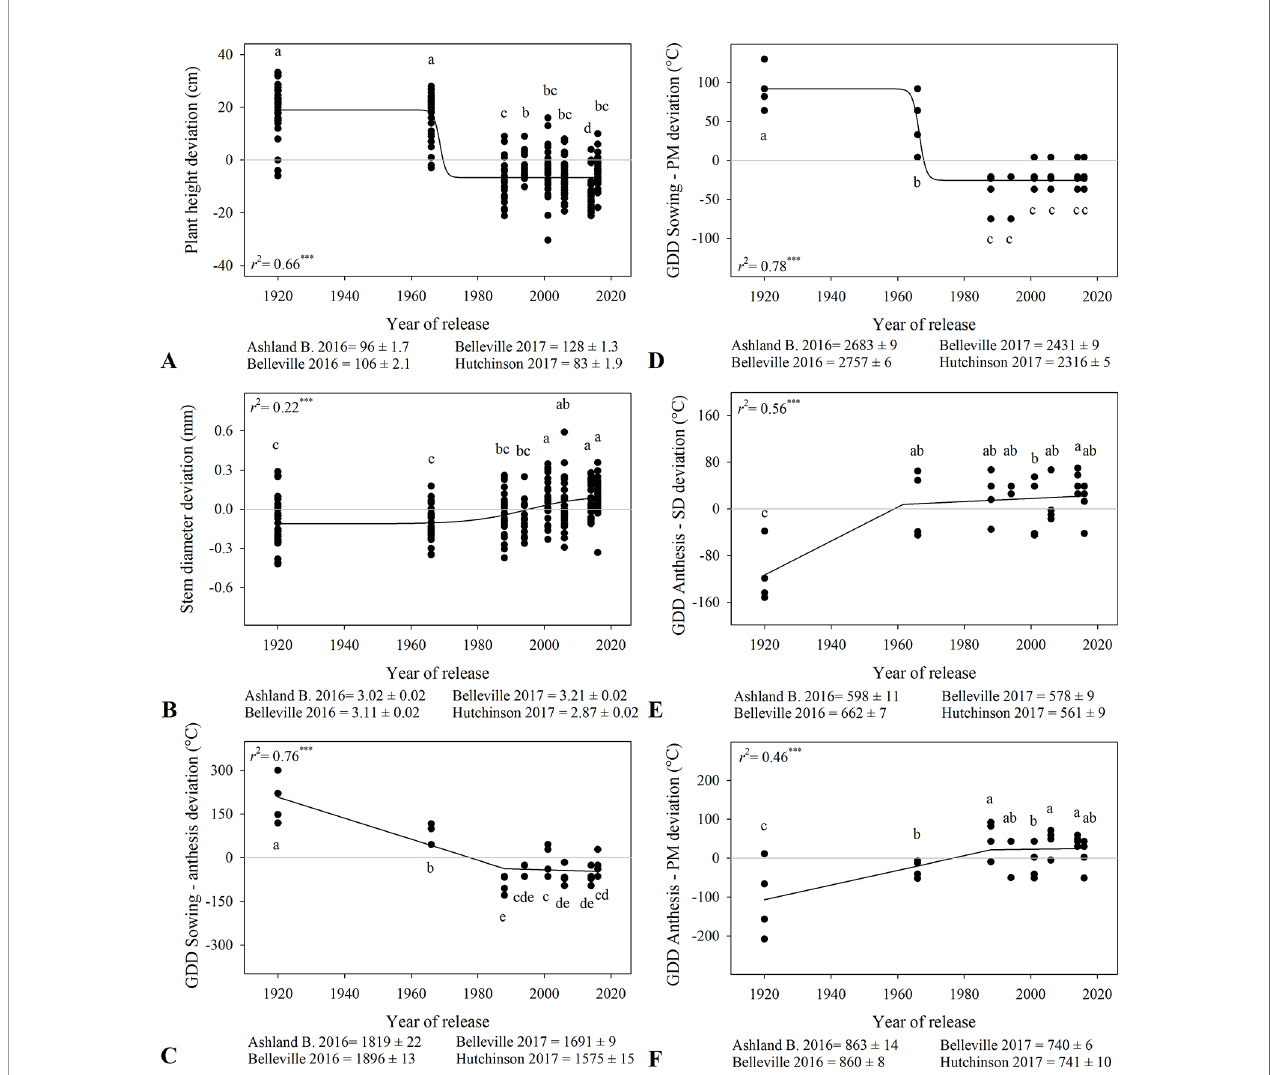
FIGURE 1 | Relationship between year of release and plant height (A) , stem diameter (B) , and thermal time from sowing to anthesis (C), sowing to physiological maturity (D), anthesis to soft dough (E), and anthesis to physiological maturity (F) . Values correspond to the data of four site-years during two growing seasons (2016-2017 and 2017-2018). Mean for all varieties in each site and year. All models are signi fi cant at P < 0.0001. Varieties followed by the same letter are not statistically different at a =